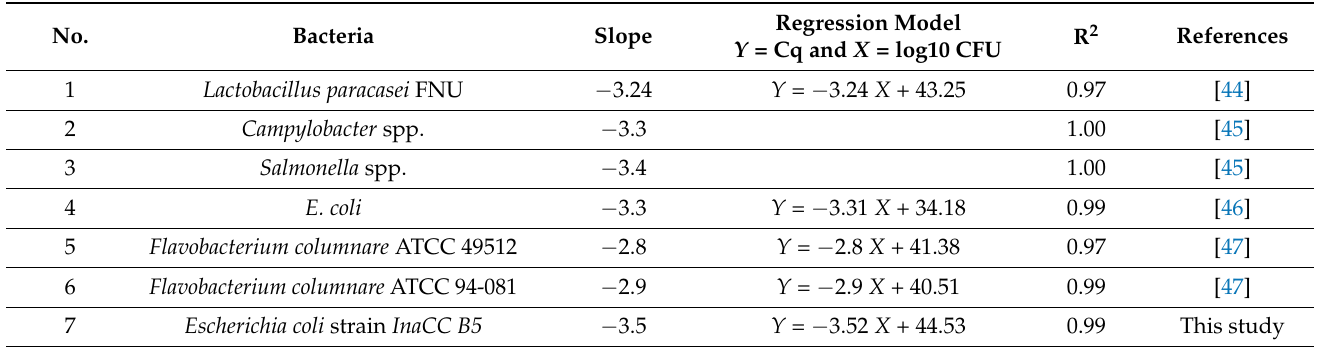
Table 2. Regression models of Cq vs. log10 CFU for various bacteria groups.